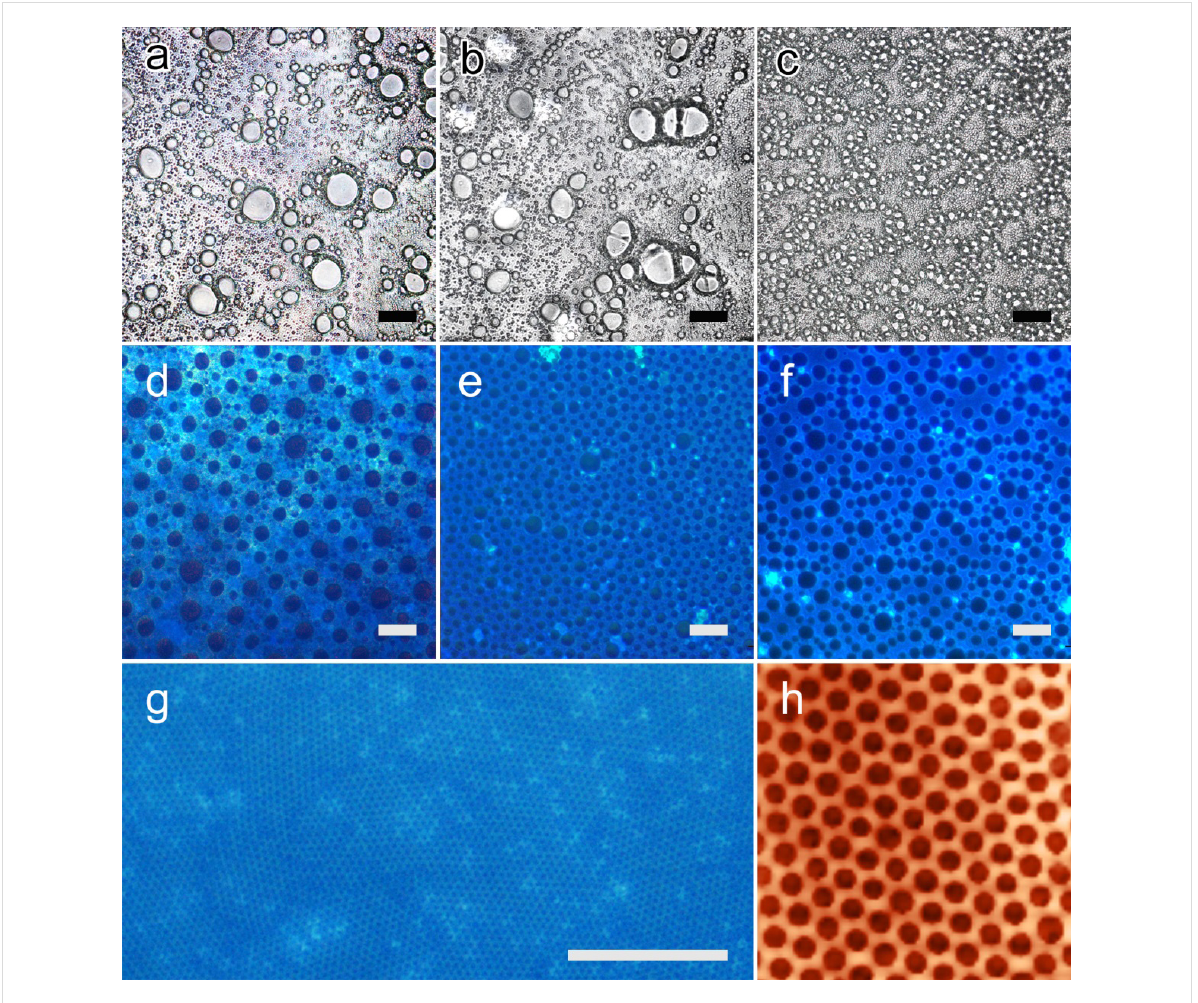
Figure 5: (a–c) Microscopy images of films of PT5, PT15 and PT30 cast under breath figure conditions. (d–f) Fluorescence microscopy images of PT5, PT15 and PT30 films prepared under the same conditions, after the addition of free TF (0.4% w/w). (g) Highly ordered microporous film of PT30 after optimization of parameters. (h) AFM view of a 10 × 10 µm 2 area of the same film. All scale bars are 20 µm